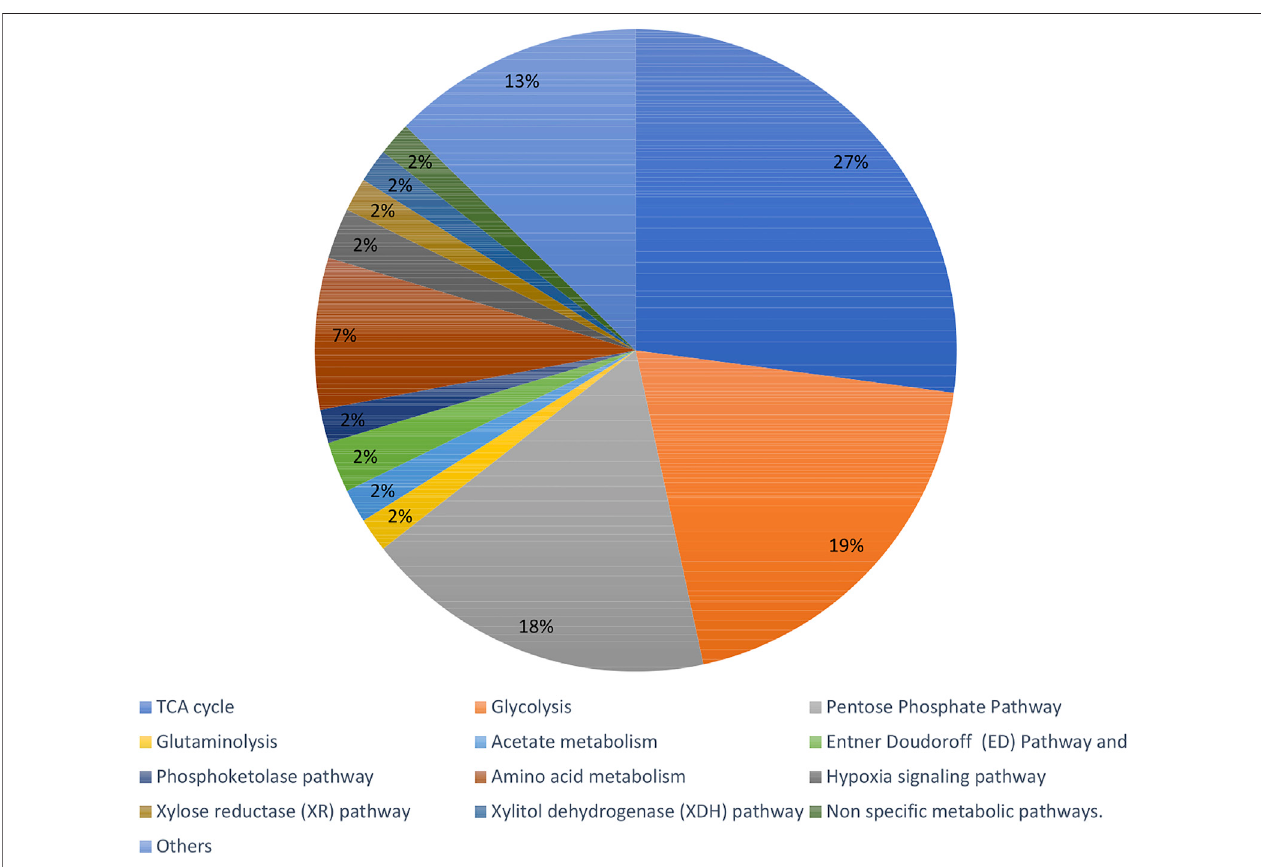
FIGURE 8 | Summary of the commonly described pathways within fl uxomic